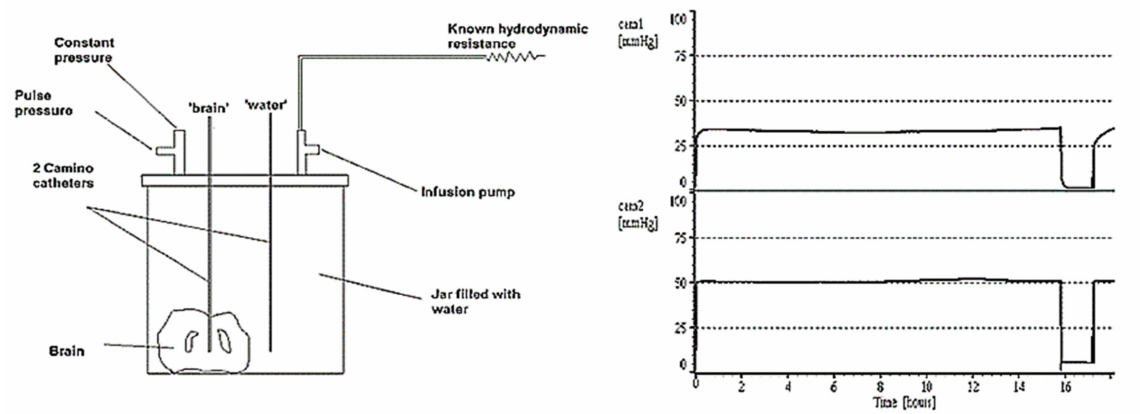
Figure 3. The ‘dead brain’ in a jar (pressurised externally). The microsensor in the brain tis- sue(cam1)shows a pressure measured at nearly 20 mm Hg lower than that of the water